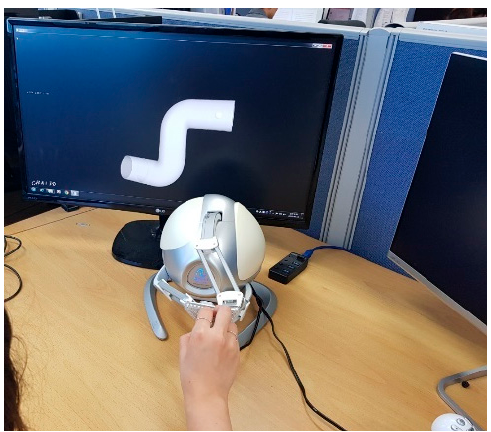
Figure 2. Upper limb rehabilitated by catching the haptic probe and passing through the three- dimensional rehabilitation model.